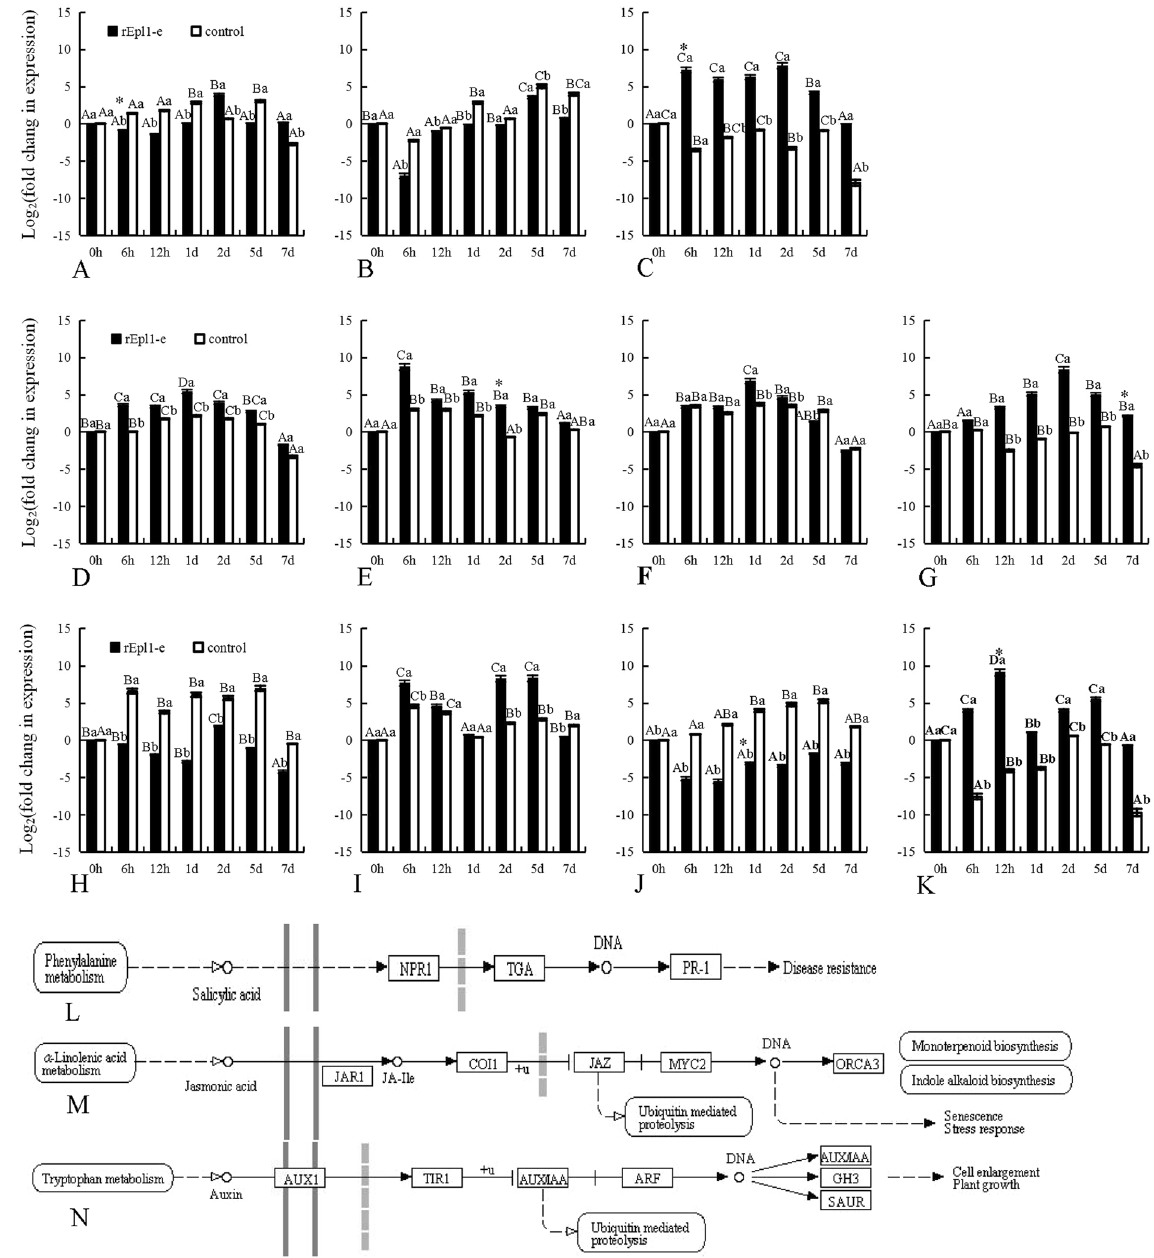
Figure 6. Transcription of 11 genes related to hormone signaling in Populus davidiana × P . alba var. pyramidalis (PdPap) seedlings under rEpl1-e induction. X-axis: time points, Y-axis: expression level = Log 2 (fold change in expression). ( A – C ) The expression levels of NPR1 , TGA , and PR1 in the SA signal transduction pathway ( L ); ( D – G ). The expression levels of COI , JAZ6 , MYC2 , and ORCA3 in the JA signal transduction pathway ( M ); ( H – K ). The expression levels of TIR1 , IAA8/AUX , MP/ARF , and GH3 in the auxin signal transduction pathway ( N ). ( L – N ) The plant hormone signal transduction of the KEGG software from the Kanehisa laboratory (http://www.genome.jp/kegg-bin/show_pathway?map04075). Different capital letters represent significant differences among different time points of treatment or the control group; different lowercase letter represent significant differences between the treatment and the control at the same time point; * significant difference between rEpl1-e and rEpl1-p treatments at the same time point. All significances were at p < 0.5. All experiments were performed three times. The quantitative data are presented in